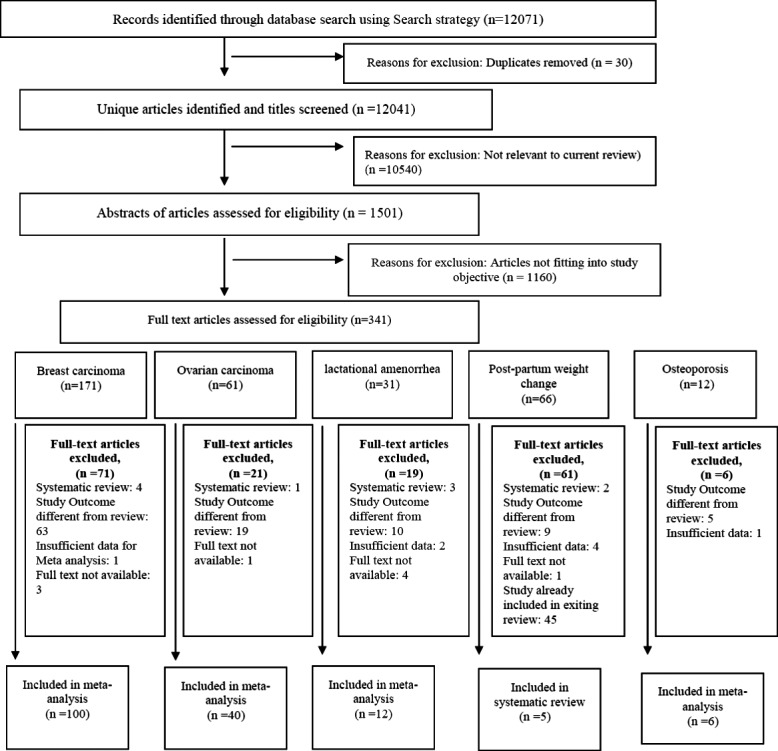
: Prisma Flow chart.